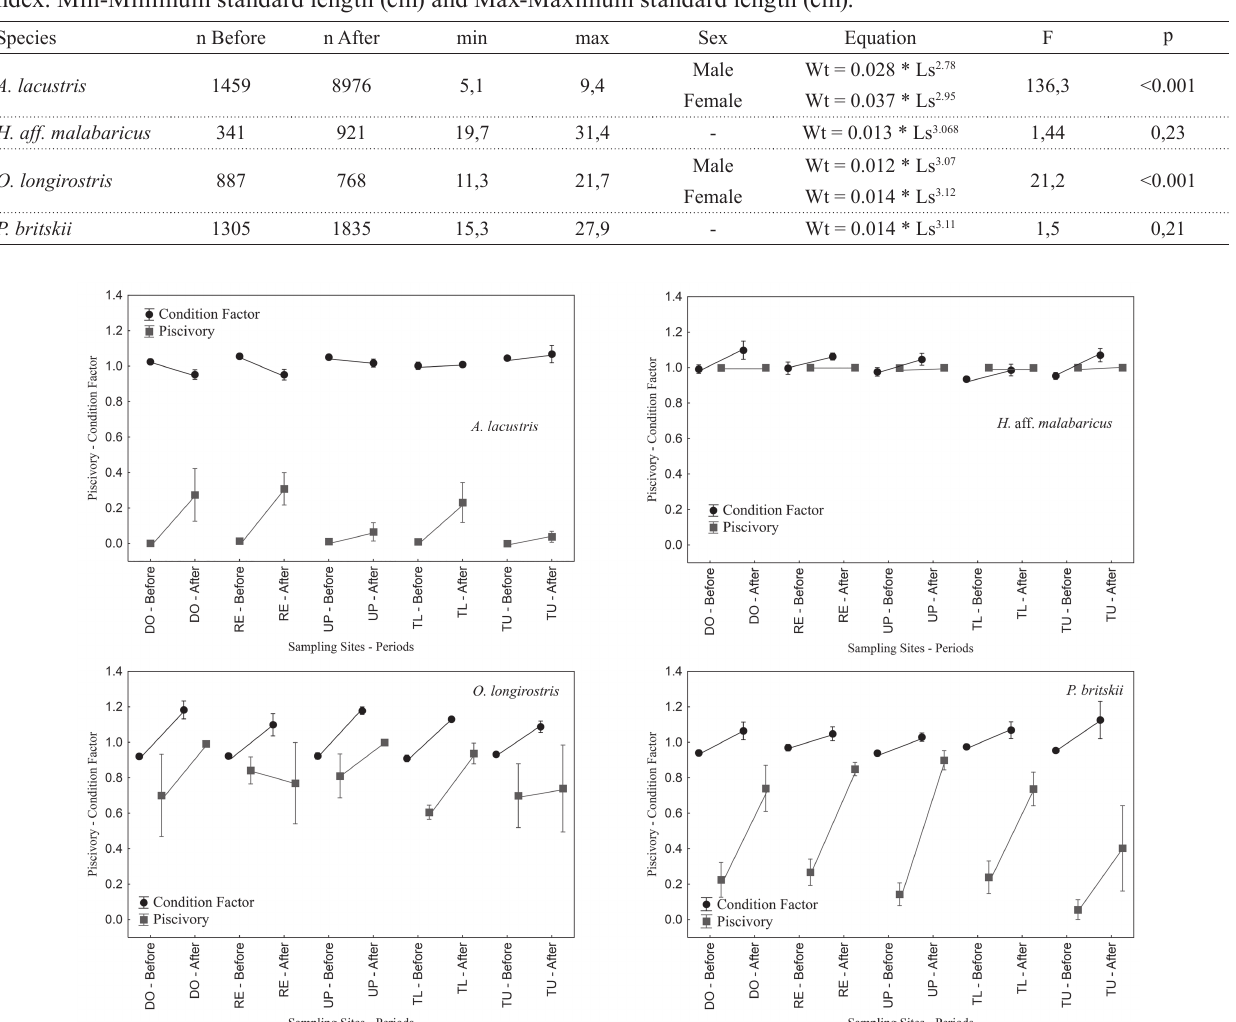
Fig. 3. Piscivory (%) and mean condition factor of the analysed species from Iguaçu River in the Salto Caxias Reservoir influence, before and after damming and sites (RE - reservoir region; DO - downstream; UP - upstream from the Iguaçu River; TL - tributaries lower section; TU - tributaries upper section). Vertical bars= standard error.